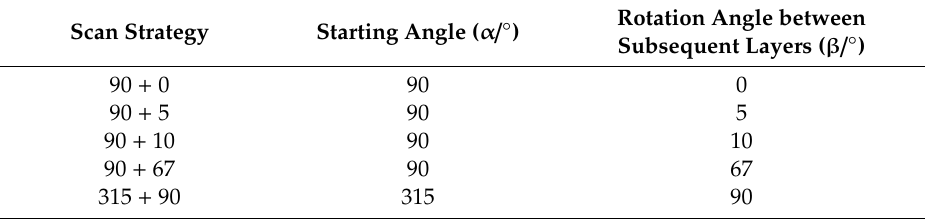
Table 2. Five scanning strategies used in SLM fabrication defined by the starting angle α and the interlayer rotation angle β